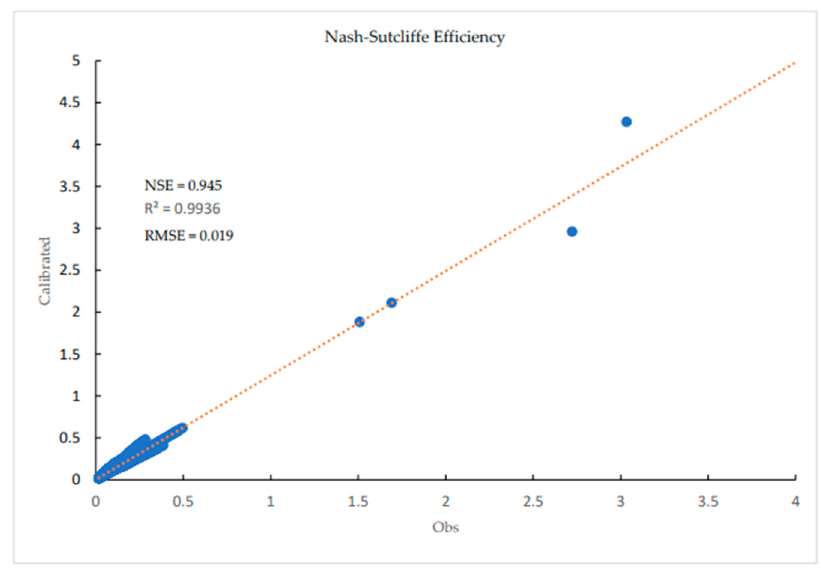
Figure 5. The SIMHYD model performance criteria analyzed at Tharwa sub-catchment.